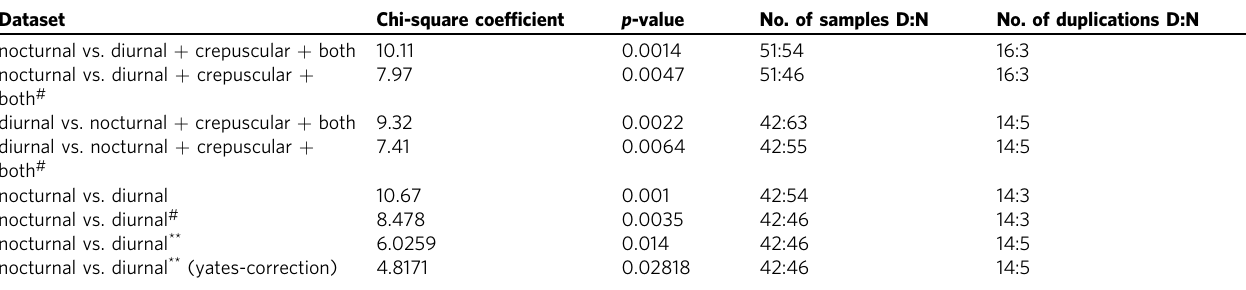
Table 1 Chi-square values for nocturnal vs. diurnal Lepidoptera species, including and excluding crepuscular and “ both ” species. Dataset Chi-square coef fi cient p -value nocturnal vs. diurnal + crepuscular + both 10.11 diurnal vs. nocturnal + crepuscular + both